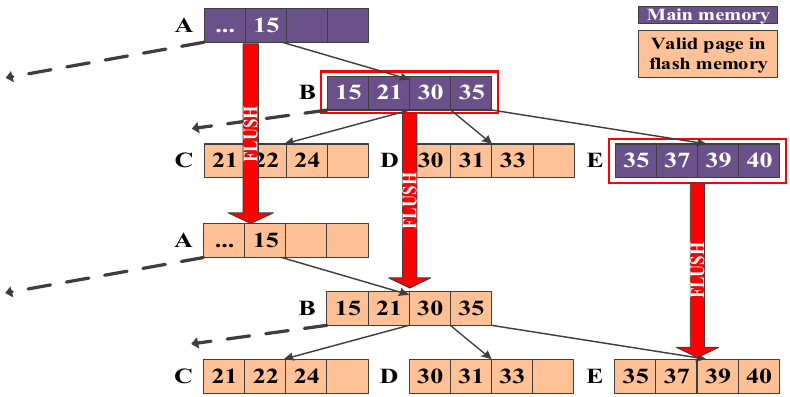
Figure 11. Example of flushing memory nodes.